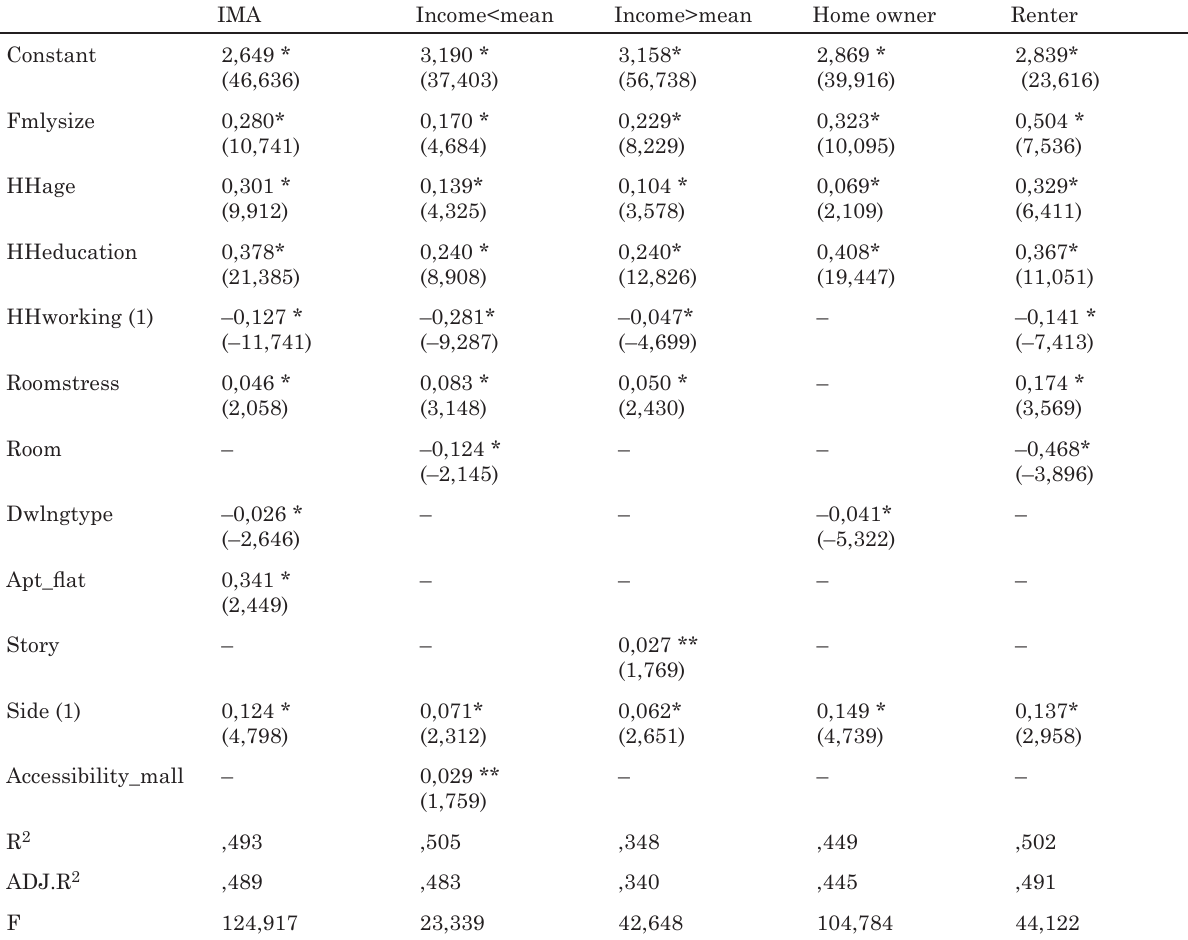
Table 4. The housing choice structure of households in the